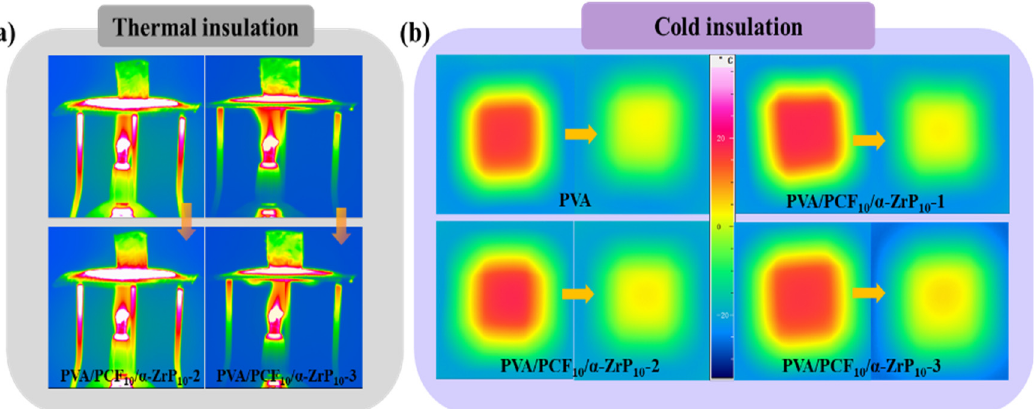
Figure 10. ( a ) Thermal insulation properties of PVA/PCF 10 / α -ZrP 10 -2 and PVA/PCF 10 / α -ZrP 10 -3 aer- ogels; ( b ) Cold insulation properties of PVA and PVA/PCF 10 / α -ZrP 10 -x aerogels. aerogels; ( b ) Cold insulation properties of PVA and PVA/PCF 10 / α -ZrP 10 -x